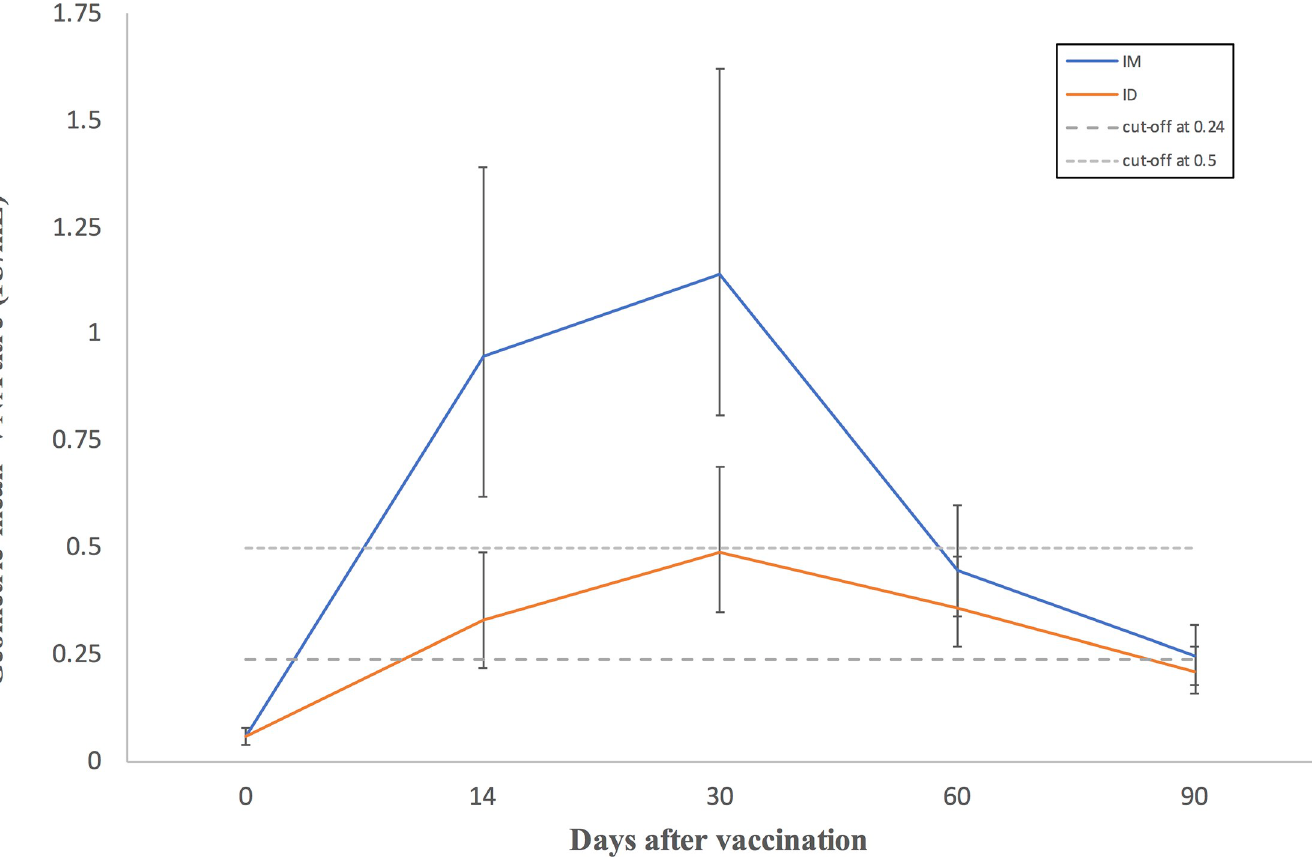
Fig 1. Geometric mean VNA titres of intramuscularly (im) and intradermally (id) vaccinated cattle on 0, 14, 30, 60 and 90 days post vaccination. The error bars indicate 95% confidence interval.